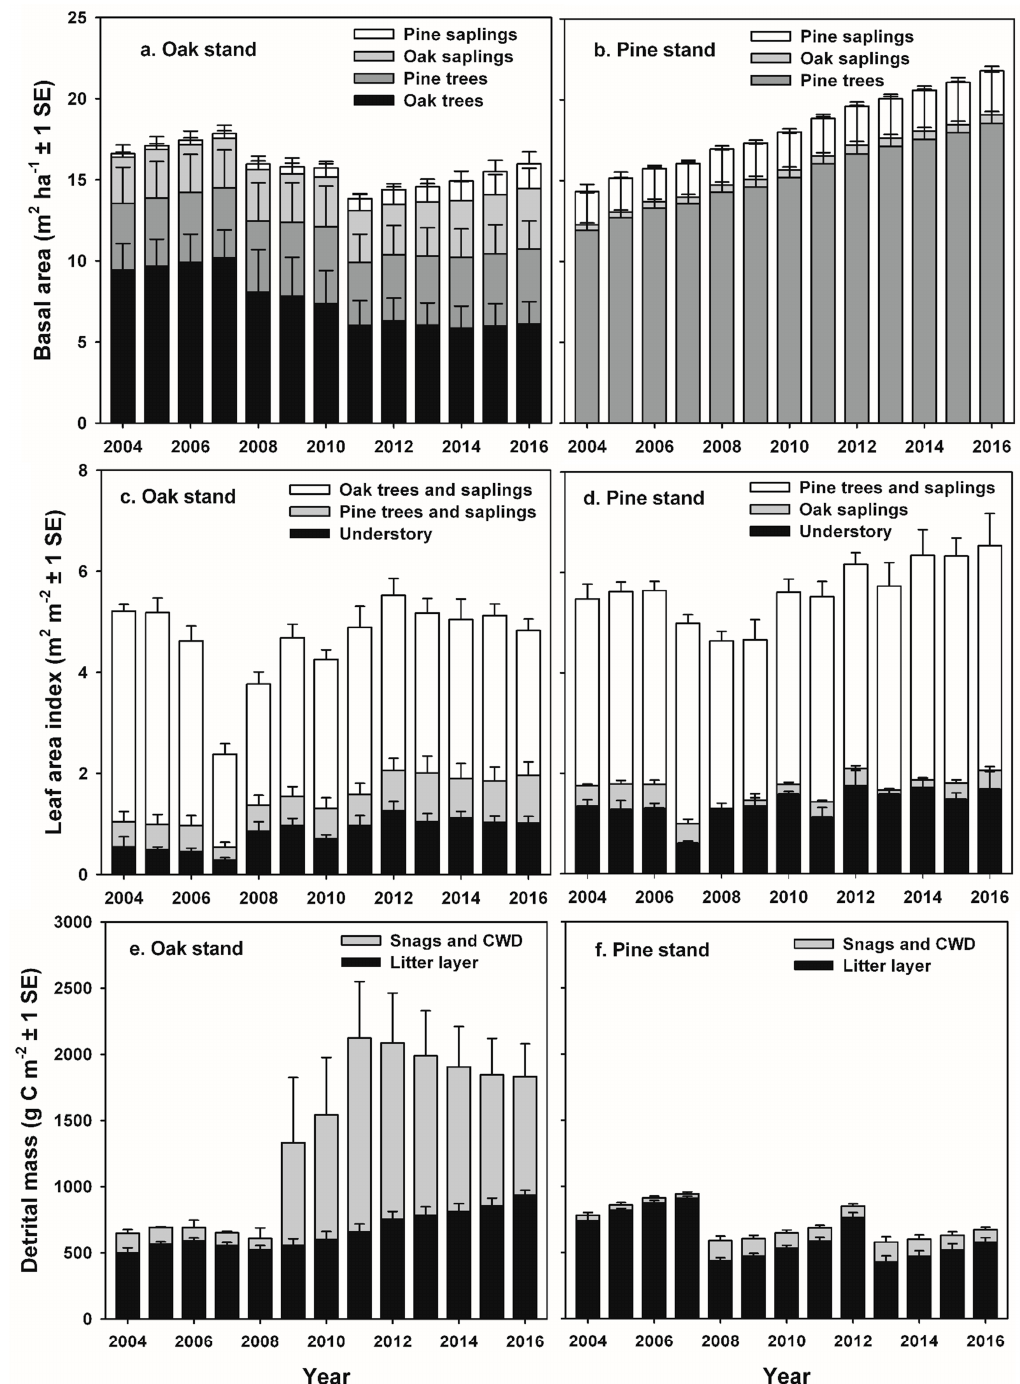
Figure 3. Biometric measurements at the oak and pine stands. Basal area of oak and pine trees (>12.5 cm diameter at breast height (DBH)) and saplings (2.5 to 12.5 cm DBH) at the ( a ) oak and ( b ) pine stands. Values are mean m 2 ha − 1 ± 1 SE for tower plots sampled annually. Leaf area index (LAI) of oak trees and saplings, pine trees and saplings, and understory shrubs and scrub oaks at the peak of the growing season at the ( c ) oak and ( d ) pine stands. Pine data is expressed as all-sided LAI, and values are mean m 2 m − 2 ± 1 SE for the tower plots. Mass of fine litter in the L horizon of the forest floor, and the sum of snags and coarse woody debris at the ( e ) oak and ( f ) pine stands. Values are mean g C m − 2 ± 1 SE for the tower plots. CWD: coarse woody debris.